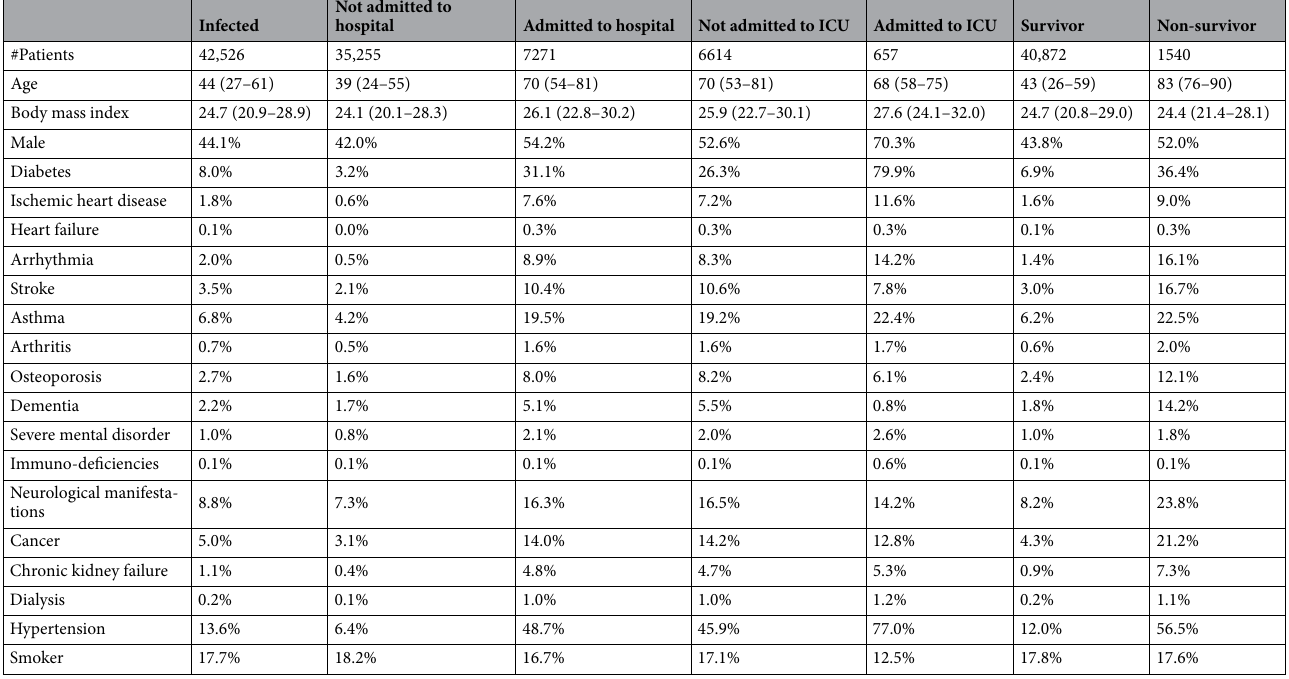
Table 2. Data set statistics: basic patient information (BMI, age, sex), patient comorbidities and smoker/non- smoker status. For binary variables, we report the occurrence in percent; for continuous variables, we report the median and interquartile range.